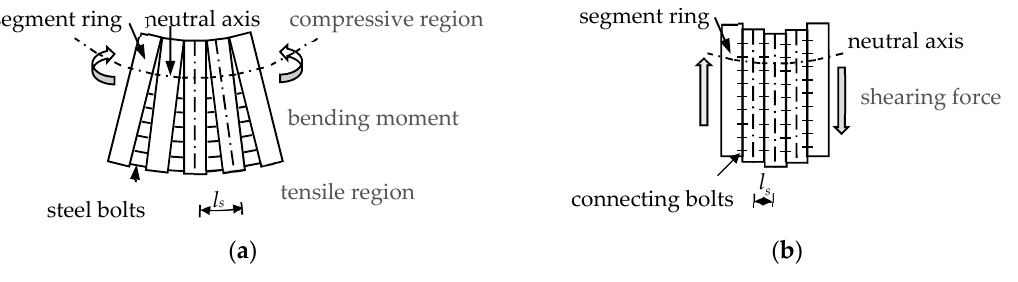
Figure 2. The diagrams used for the definition of structural damage. ( a ) Bending mode; ( b ) Dislocation mode.